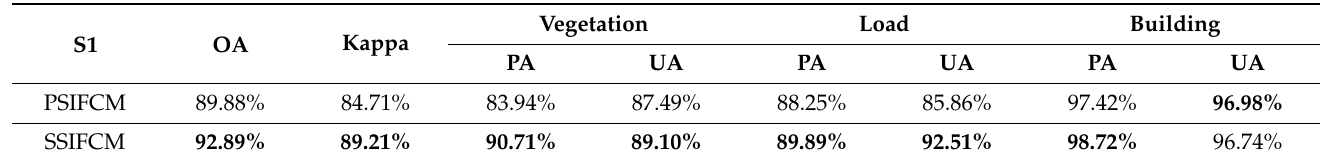
Table 1. Evaluation of S1 image pixel-level and object-level spatial intuitive fuzzy clustering algo- rithms classification results.